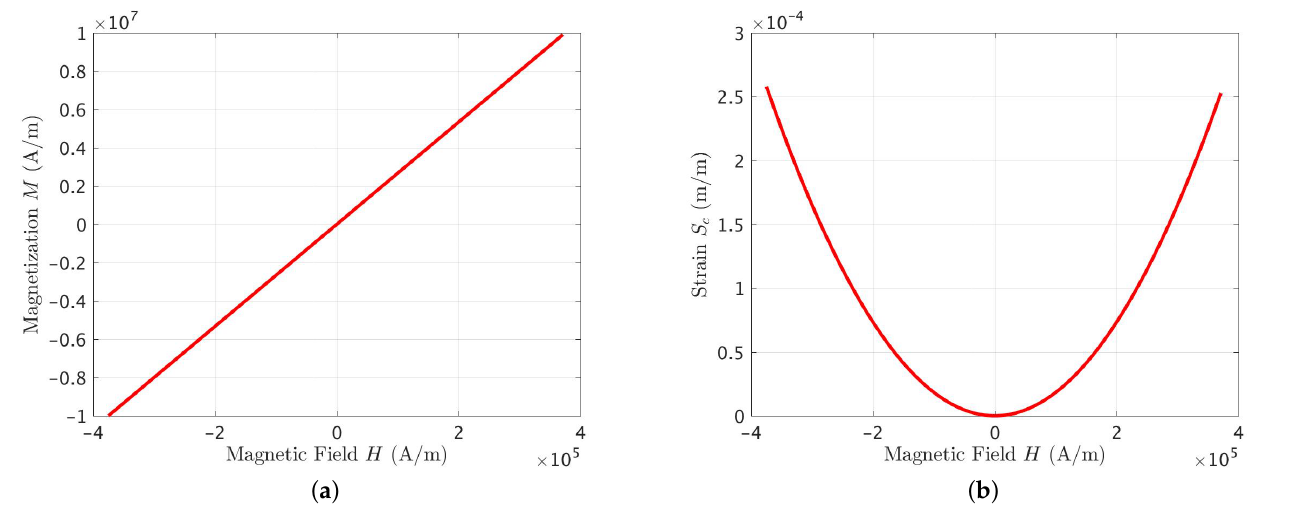
Figure 2. Anhysteretic response of magnetization and structural strain to increasing magnetic field strength for a magnetostrictive